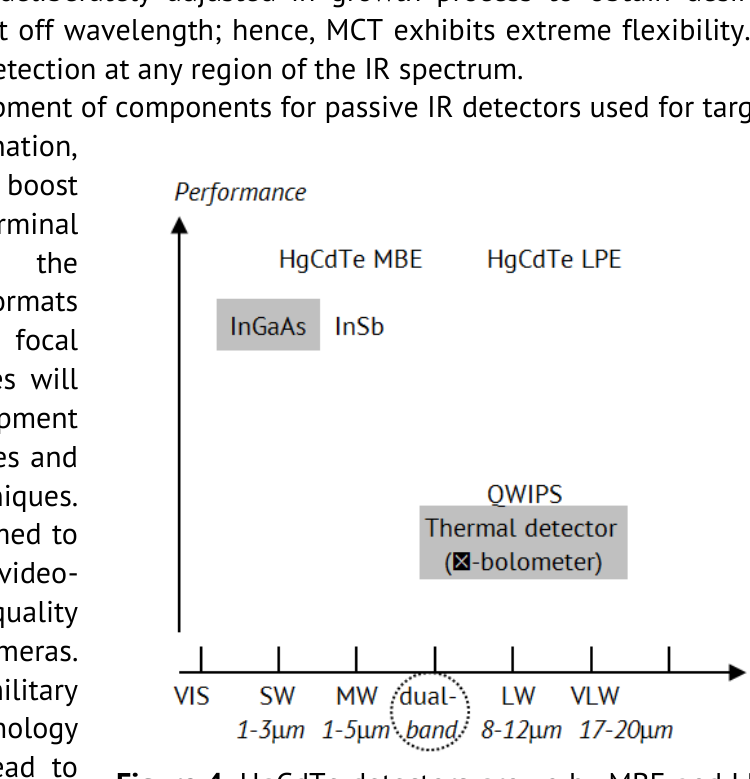
Figure 4. HgCdTe detectors grown by MBE and LPE deliver better object identification capability than the detectors, such as -bolometers and those based on InGaAs and InSb = uncooled ; all other: cooled (after